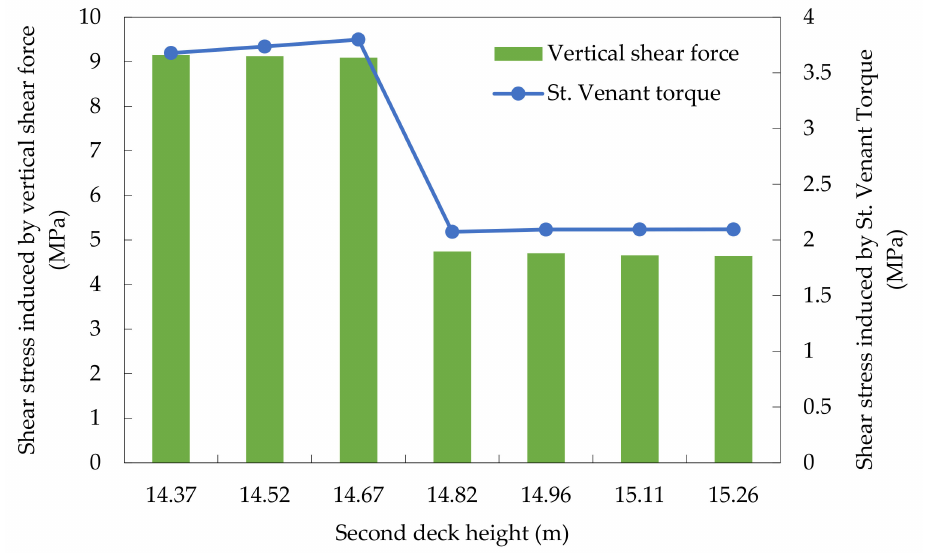
Figure 15. Shear stresses variation induced by vertical shear forces and St. Venant torque values of the torsion box